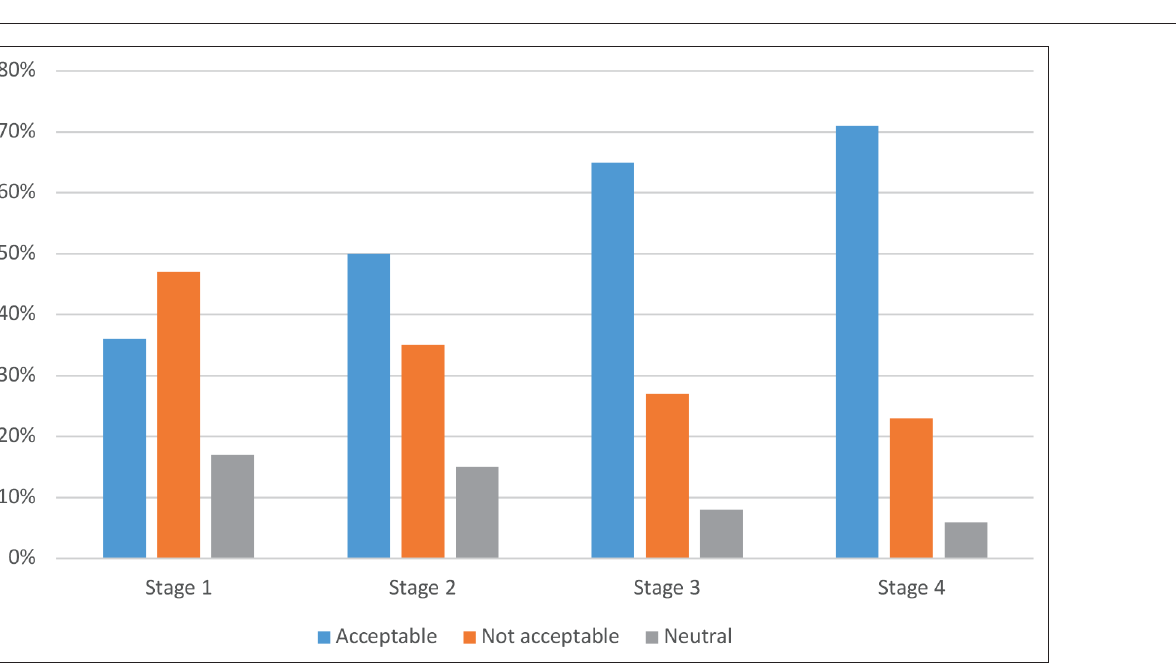
Figure 1 Acceptability of performing euthanasia at different stages of dementia. Stage 1 = early dementia (moments of forgetfulness, fear of what will come, and sickness awareness); stage 2 = progressive dementia (disorientation, reduced awareness of time, increasingly worse recognition of loved ones); stage 3 = advanced dementia (complete withdrawal, without any sense of time, place, or person, endlessly engaged in certain movements and/or sounds); stage 4 = end- stage dementia (contactless, hardly any reaction, only physically